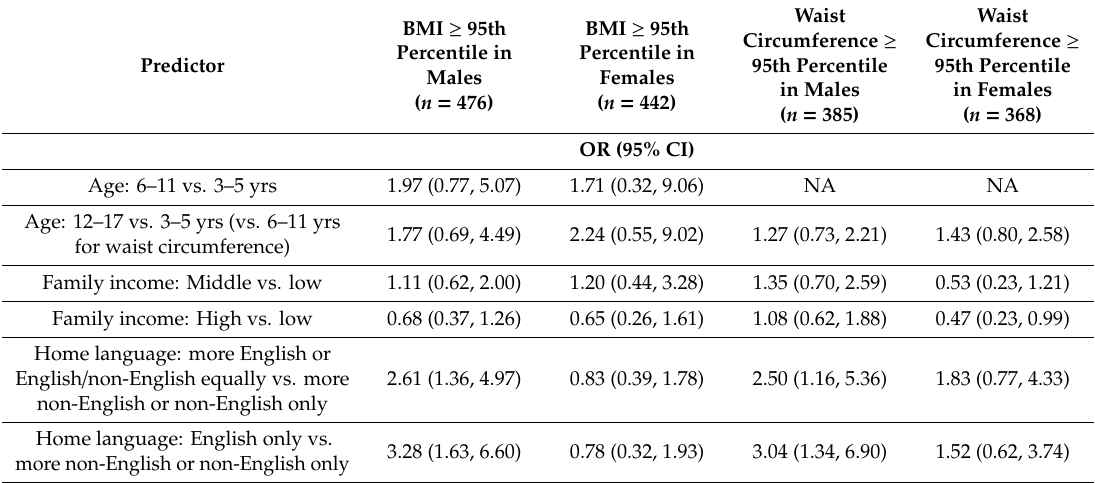
Table 3. Associations of acculturation with obesity and central obesity in Asian American